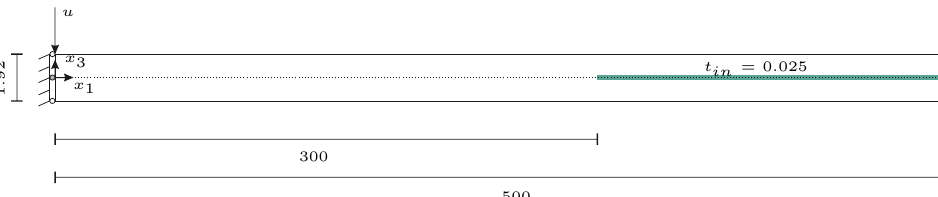
Figure 5. Sketch of the two-dimensional numerical model used to simulate the interaction between the GUW propagation and a polyimide inlay (green) integrated into a GFRP laminate. All measurements are in